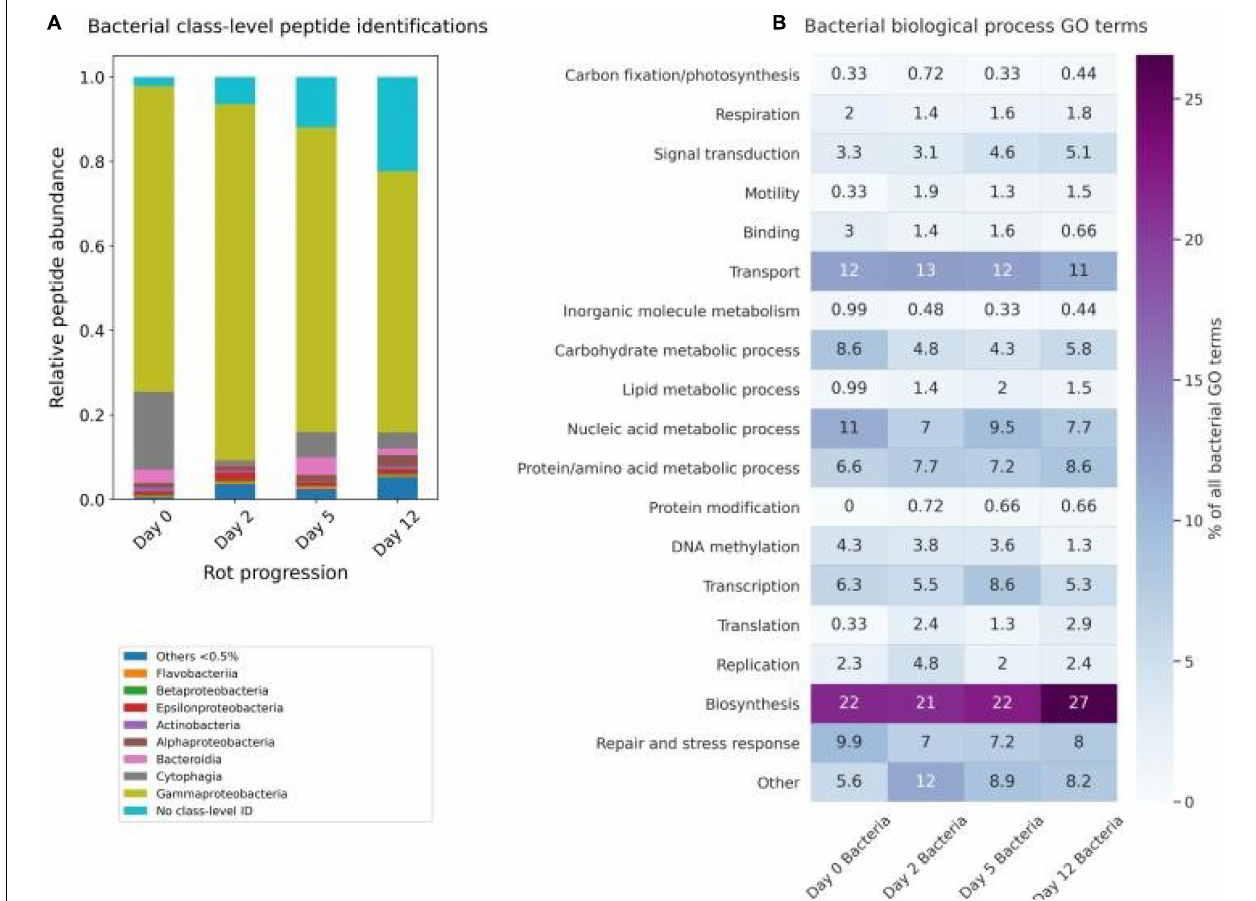
FIGURE 6 | Bacterial progression of the 12-day algal degradation. (A) Relative abundance contribution of the major bacterial taxonomic classes ( > 0.5%) from the time point proteomes adjusted by relative peptide area abundance. (B) The percentage of the total number of bacterial peptide biological process gene ontology (GO) terms. GO terms shown were condensed from a broader set to eliminate redundancy for ease of visualization using the REViGO (available http://revigo.irb.hr/) and further manually organized into broader categories.